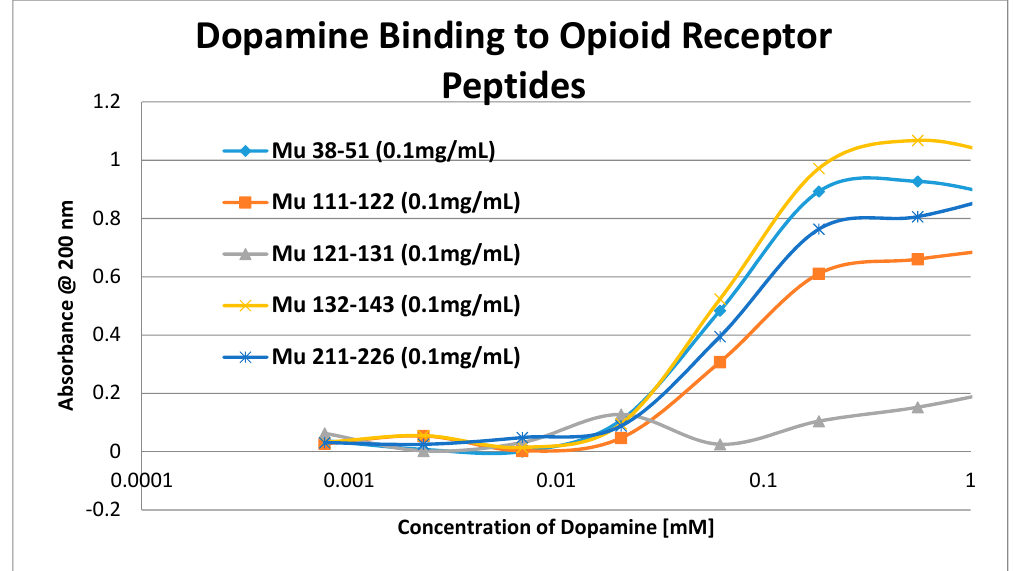
Figure 6. UV spectroscopic study of dopamine binding to mu opioid receptor (muOPR) peptides derived from the extracellular loop and adjacent transmembrane regions (see Figure 1).